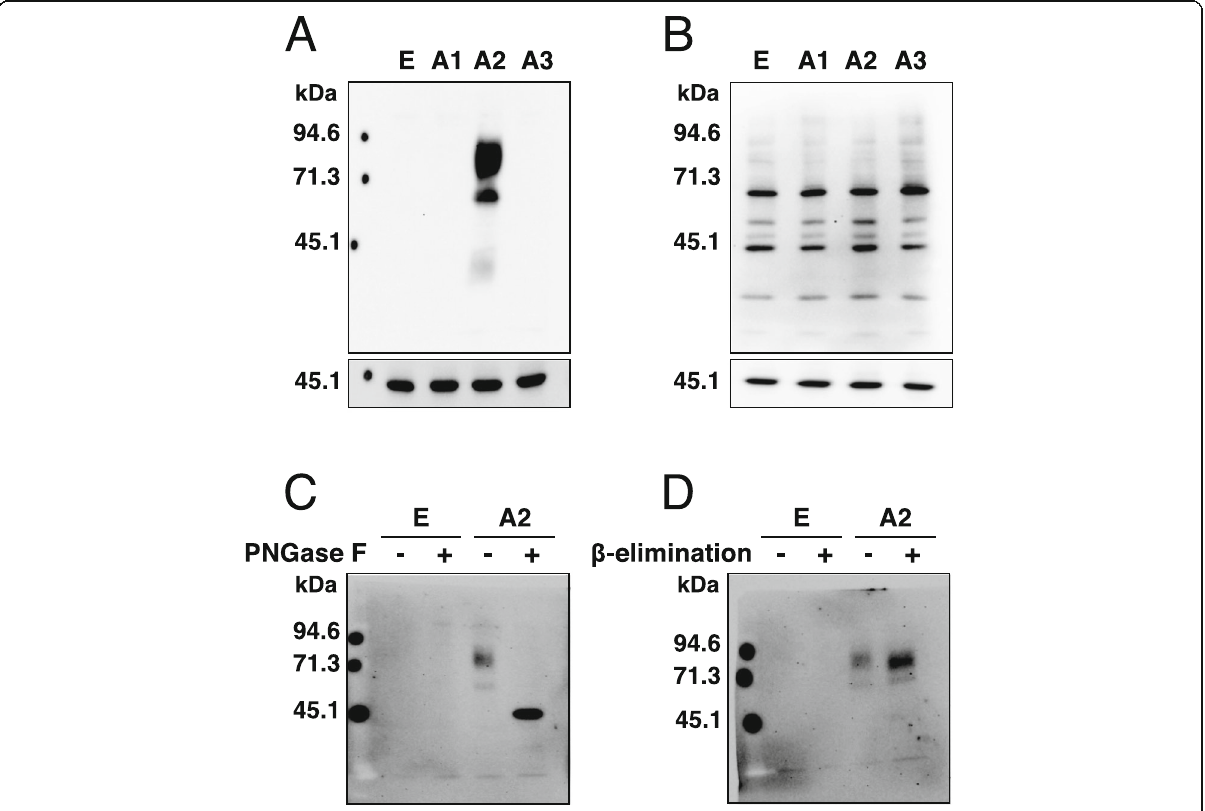
Fig. 1 Specific detection of AMIGO2 by the monoclonal antibody rTNK1A0012. The large membrane was reacted with anti-AMIGO2 antibody, while the small membrane was reacted with an anti- β -actin antibody. A Cell lysates were prepared from HepG2 cells transfected with human AMIGO1 (A1), AMIGO2 (A2), AMIGO3 (A3), and an empty vector (E). Immunoblotting with rTNK1A0012 (rTNK mAb). B Immunoblotting with sc- 373699 (sc mAb). C Cell lysates were treated with or without PNGase F and immunoblotted with rTNK mAb. D Cell lysates were treated with or without alkaline β -elimination and immunoblotted with rTNK